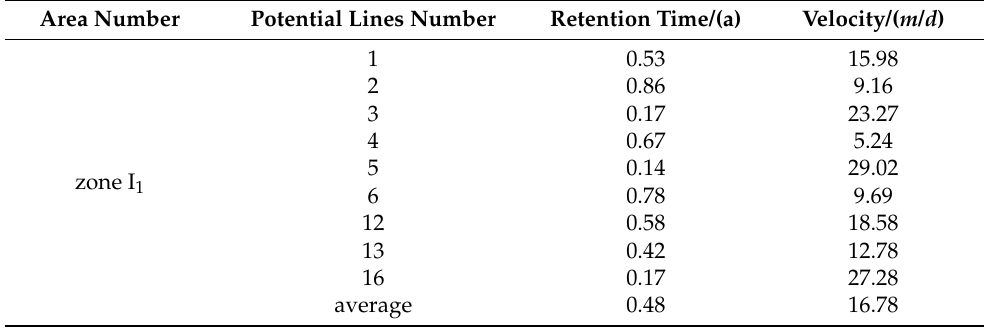
Table 4. Groundwater storage time (a) and actual groundwater velocity ( m / d ) at each sampling point in the different zones of the study